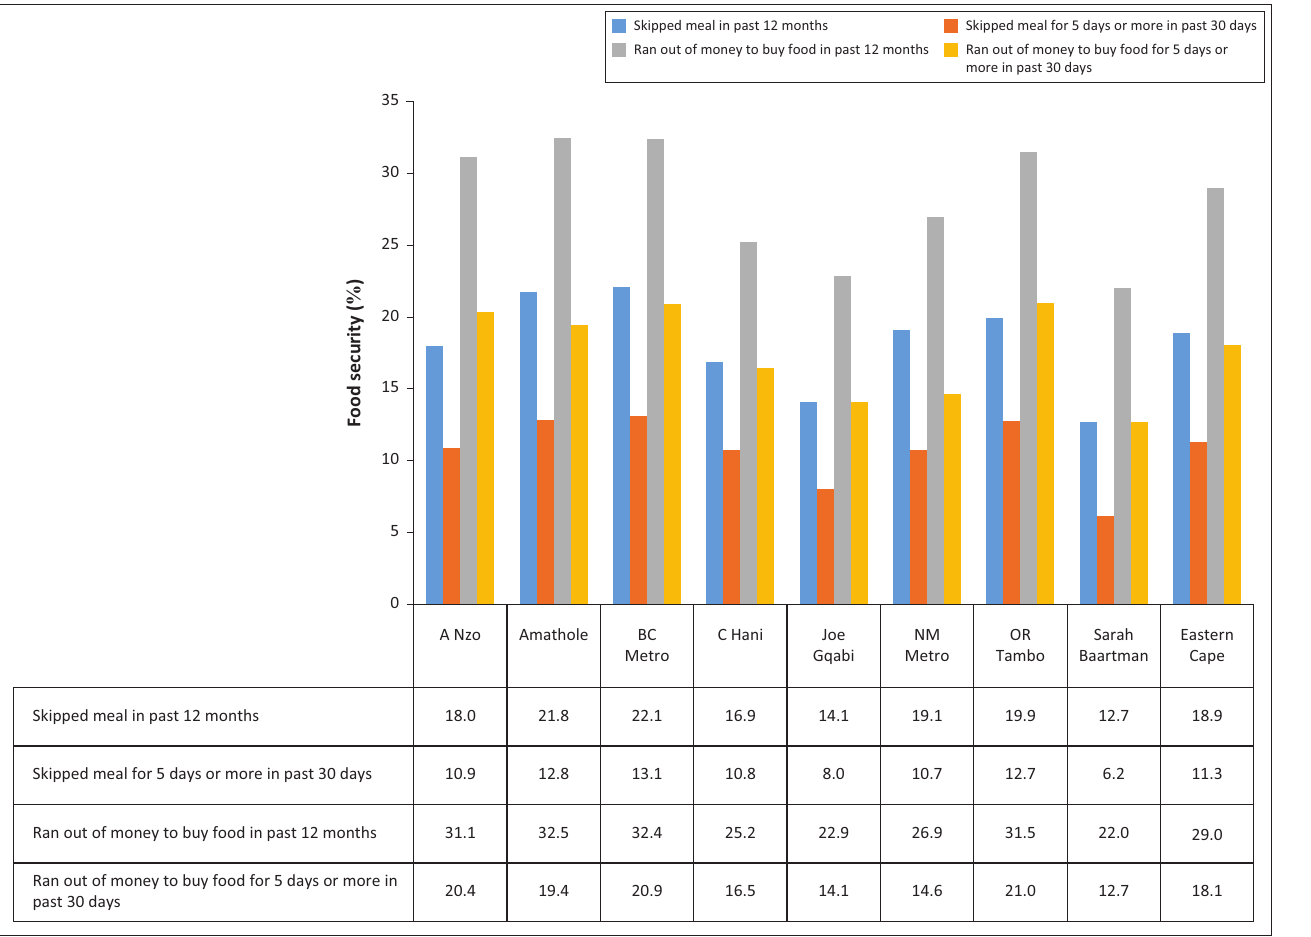
FIG URE 2: Food security indicators for the Eastern Cape,